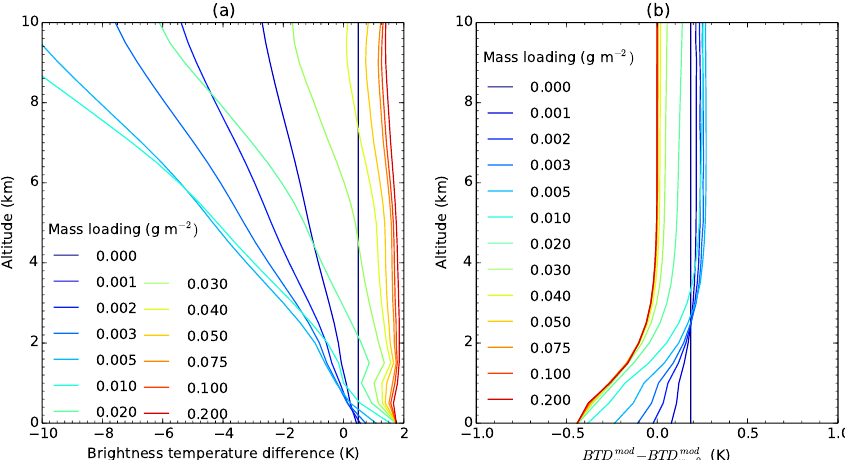
Figure 8. (a) The simulated brightness temperature difference between VIIRS bands M15 and M16, BTD V , for a 1km thick ash layer as a function of ash layer top altitude. (b) The difference BTD mod w − BTD mod varying ash mass loading (gm − 2 ) and are given in the